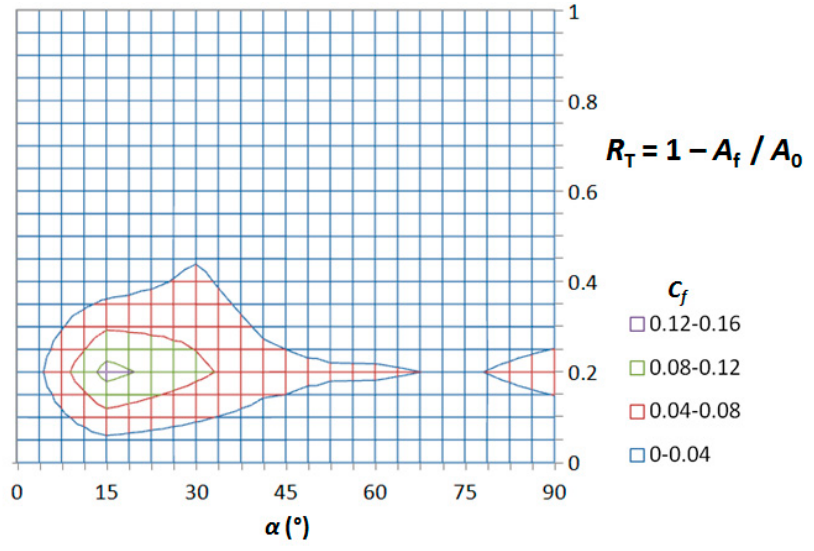
Figure 14. Central damage factors ( C f ) map in double-pass extrusion of dual-phase steel DP800 for m = 0.08, showing the minimum values.